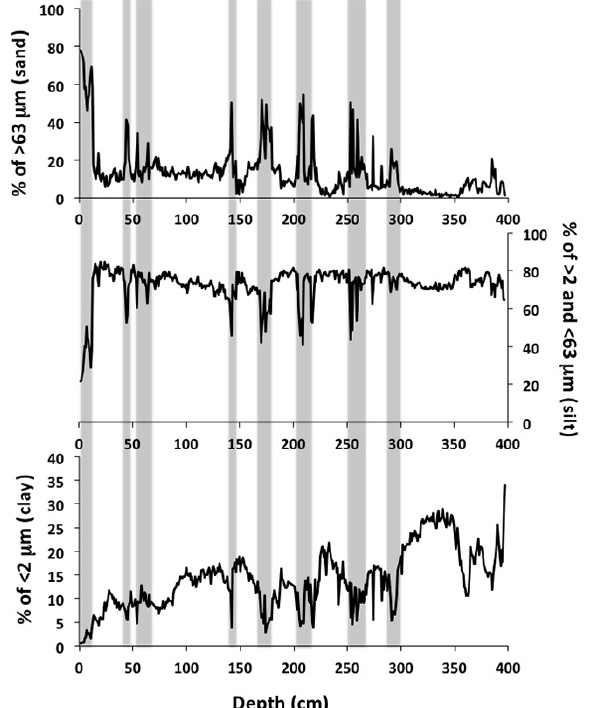
Figure 3. Grain size population from the Mar Menor MM2 record with clay (<2µm), silt (>2 and <63µm), and sand fraction (>63µm). Shaded areas mark the main variations of the sand frac-